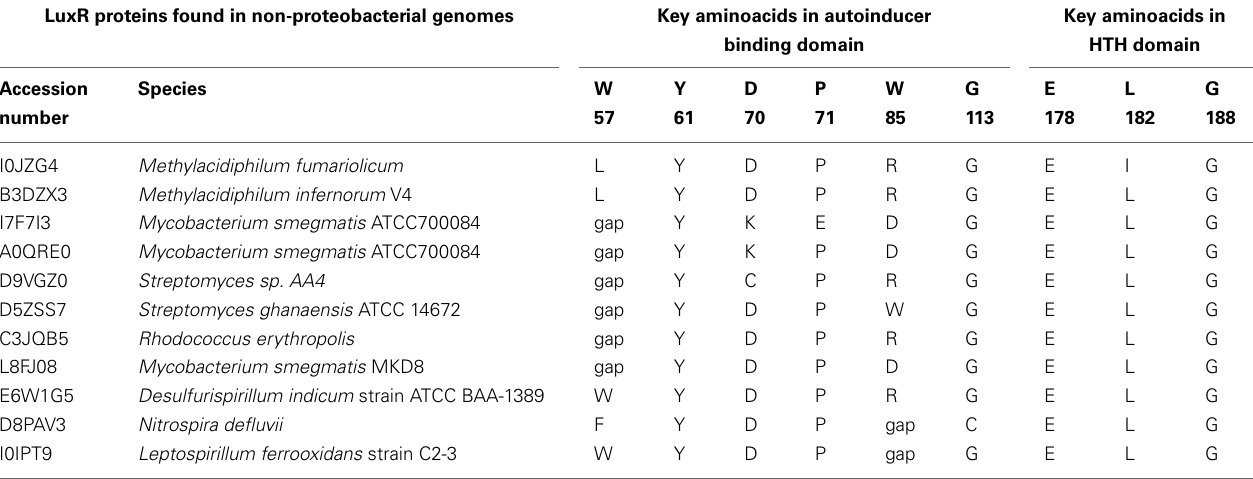
Table 2 | Conservation analyses for LuxR-solo proteins found in non-proteobacterial genomes. LuxR proteins found in non-proteobacterial